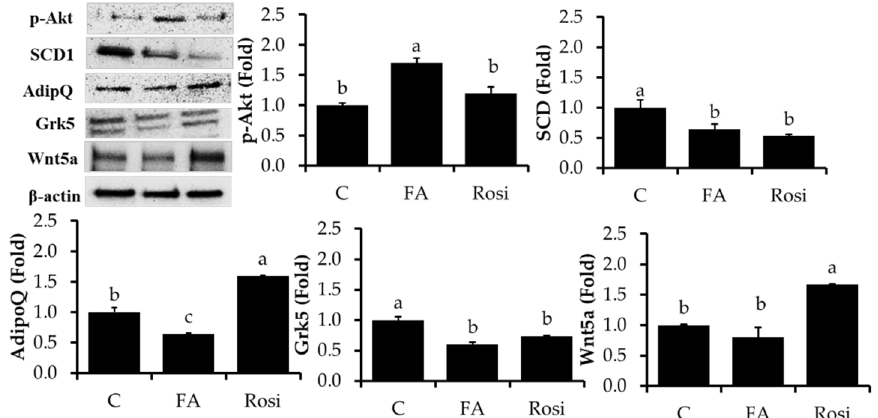
Figure 4. Lipolysis-associated proteins were analyzed by immunoblotting. After incubation of 3T3-L1 adipocytes with/without FA and rosiglitazone (Rosi) at 10 µM treatment for 8 days, the expression levels of p -perilipin, p -HSL (Ser 565), p -AKT, SCD1, Wnt5a, adiponectin Grk5, and β-actin were measured. The results are represented as the mean ± standard error of the mean three replicates. The Fluorescence intensity of the targeted proteins was normalized with housekeeping protein (β-actin) using ImageJ software. a,b,c p < 0.05 statistically significant differences between control and treated groups.